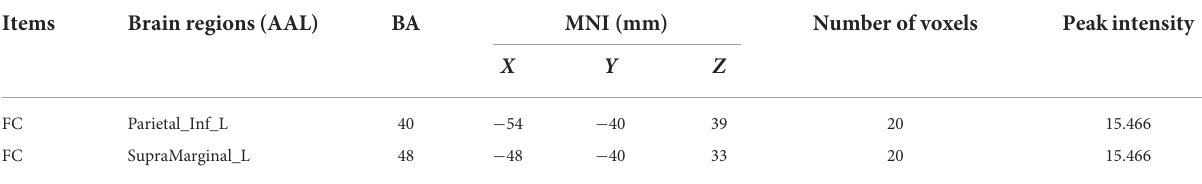
TABLE 5 Group × Time Interaction on the mOFC-Based